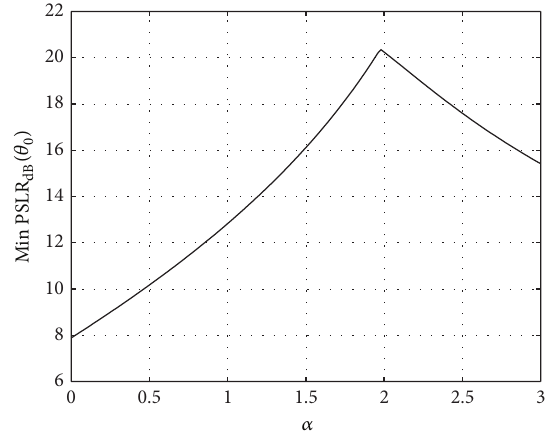
Figure 3: Trend of the PSLR as a function of the taper 𝛼 for the configuration of Figure 2.